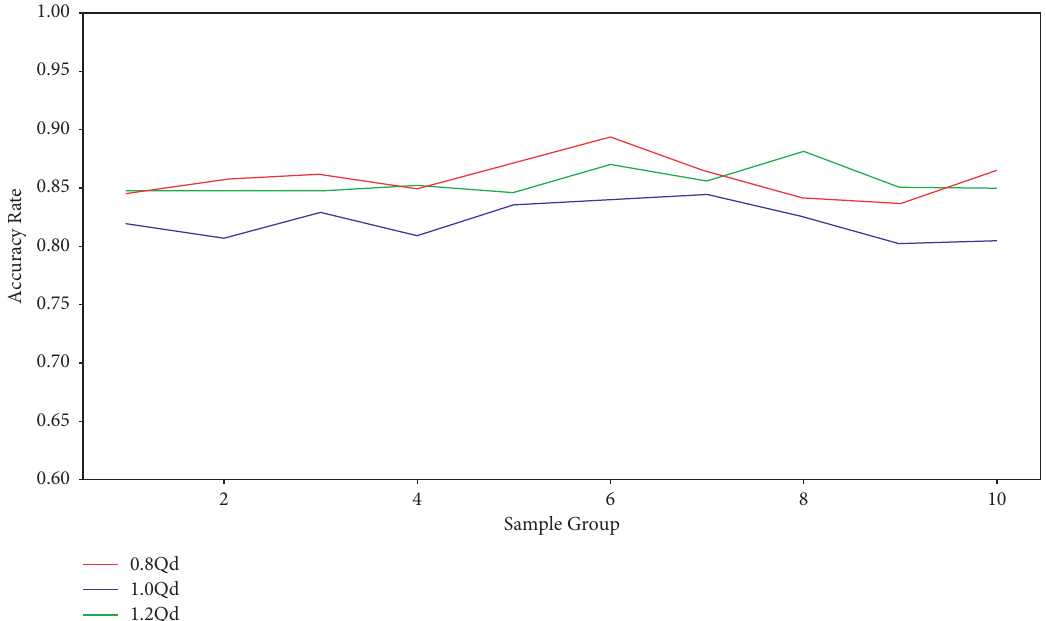
Figure 8: Model accuracy of group verification under various working